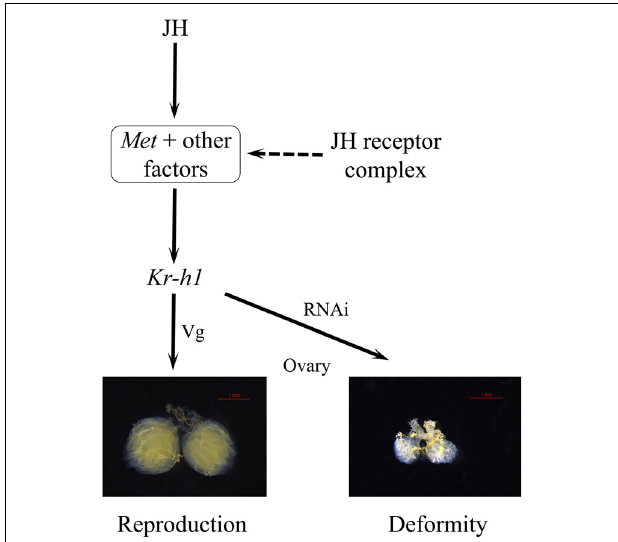
FIGURE 8 | A model for JH signaling in reproduction of B. dorsalis. The JH-receptor complex, consisting of Met and other factors, induces the expression of the transcription factor Kr-h1 that subsequently regulate the expression of Vg and the reproductive